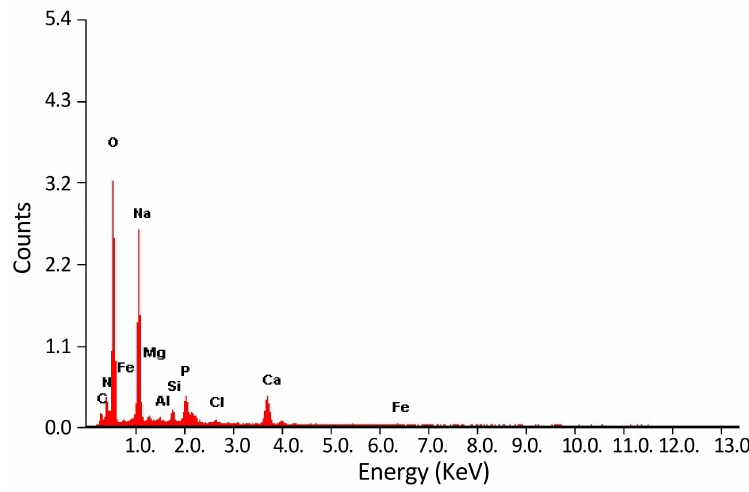
Figure 4. EDX spectrum of